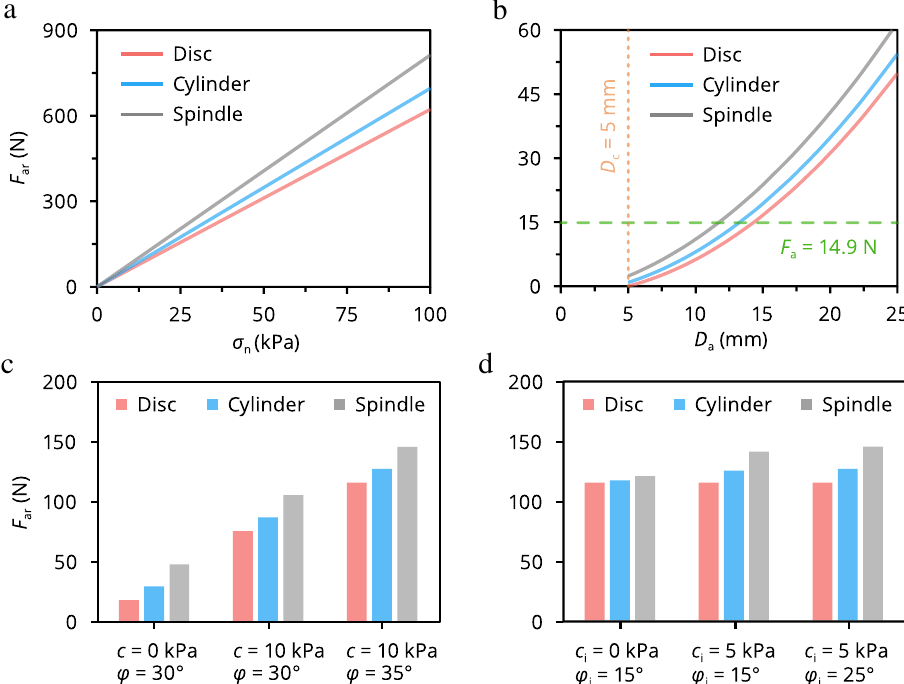
Figure 4. Parametric analysis reveals the effects on the ultimate soil–anchor interaction force F ar of variations in model parameters: ( a ) Normal stress σ n , ( b ) Microanchor diameter D a , ( c ) soil strength parameters ( c , and ( d ) soil–anchor interface strength parameters ( c i , interaction force between soil and microanchor (14.9 N corresponds to a 1% tensile strain). Parameters used in the analysis are summarized in Supplementary Table